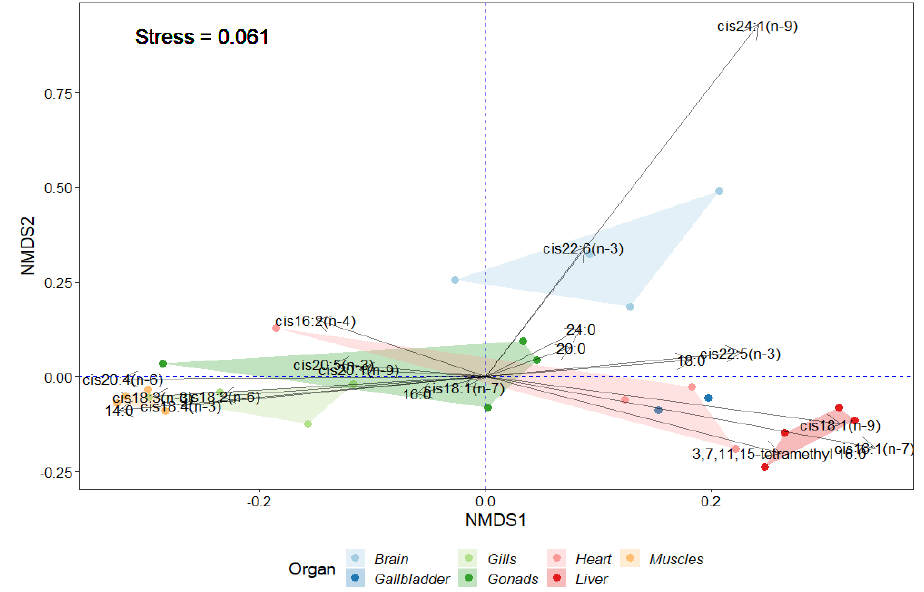
Figure 3. Visualization of the differences in the fatty acid content in different tissues of Pleuragramma antarcticum using non-metric multidimensional scaling (NMDS).